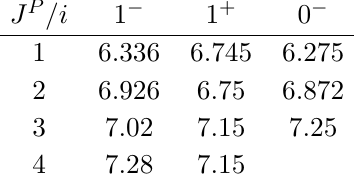
included in the Blaschke factors (C.3). i a 2